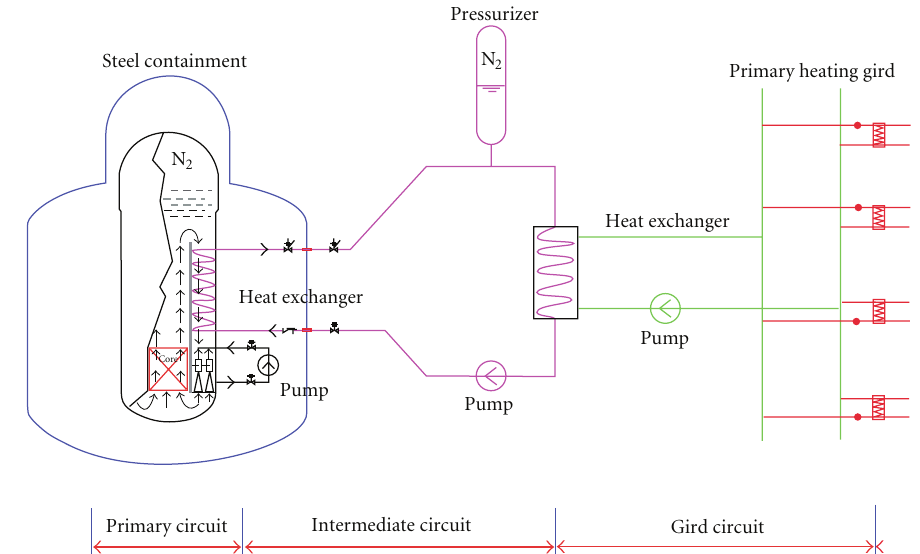
Figure 2: Low temperature, integral PWR proposed by NPIC [7].